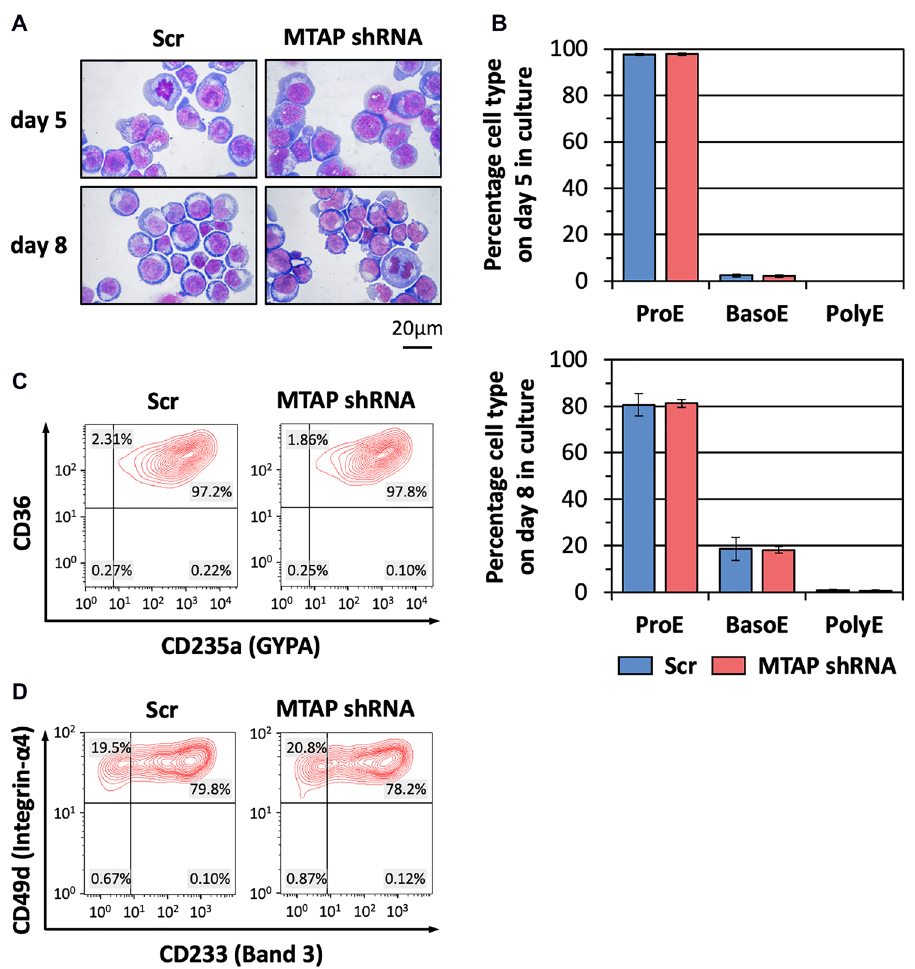
Figure 5. Erythroid differentiation is unaffected by MTAP knockdown. Differentiation of erythroblasts transduced with MTAP shRNA or control scrambled shRNA (Scr) was examined at specific time points. ( A ) Morphology of cultured cells stained with Leishman’s reagent on days 5 and 8, representative images of three independent cultures, magnification 100 ×. ( B ) Composition of cell types at different erythroid developmental stages on days 5 and 8 in culture, mean ± SD of three independent cultures, ProE proerythroblast, BasoE basophilic erythroblast, PolyE polychromatic erythroblast. ( C ) Expression of membrane markers CD235a (GYPA) vs. CD36 on day 8 analysed by flow cytometry. ( D ) Expression of membrane markers CD233 (Band 3) vs. CD49d (Integrin-α4) on day 8 analysed by flow